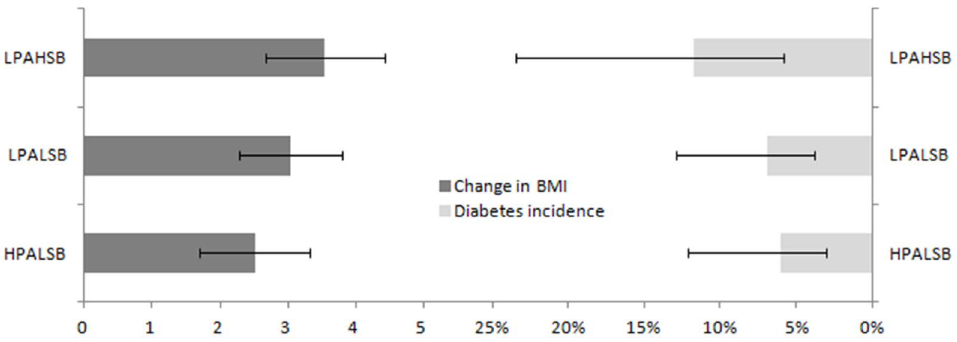
Figure 2. Adjusted change in BMI and incidence of diabetes of the three clusters (LPAHSB: low physical activity high sedentary behavior; HPALSB: high physical activity low sedentary behavior; LPALSB: low physical activity low sedentary behavior).